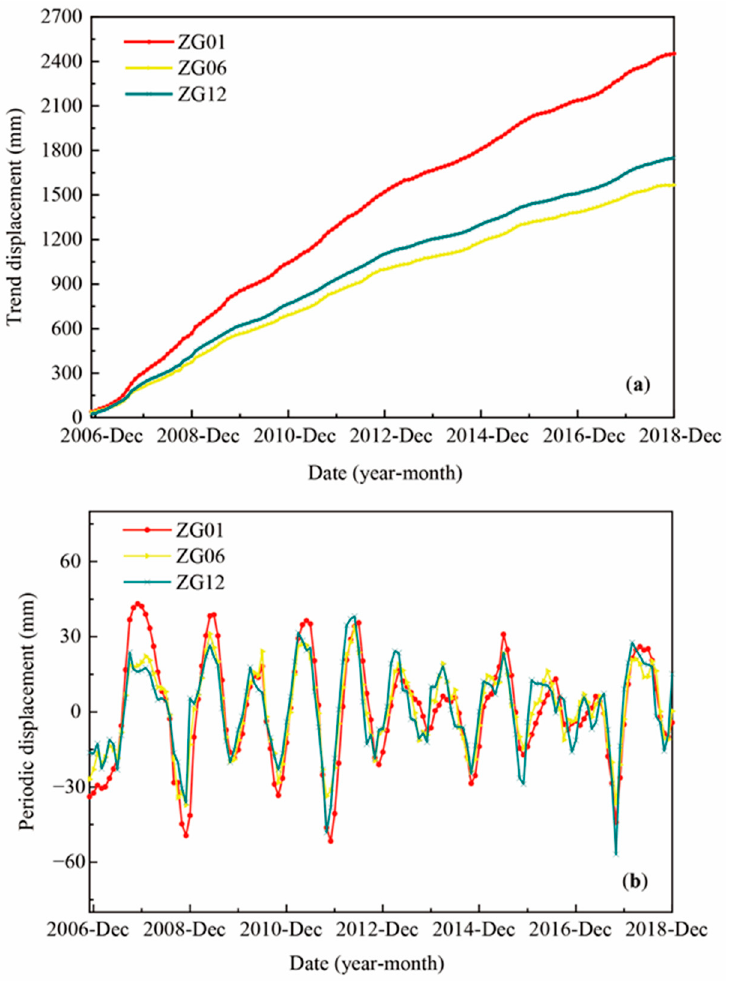
Figure 6. The extracted displacements from ZG01, ZG06, and ZG12 by VMD. ( a ) Trend displacements; ( b ) periodic displacements.